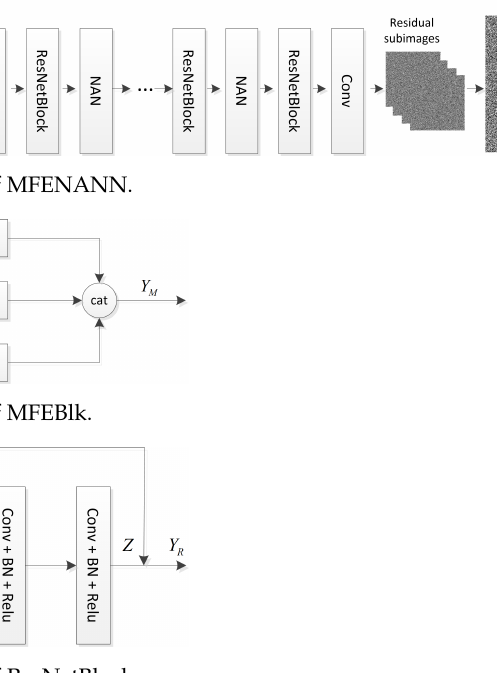
Figure 3. The architecture of